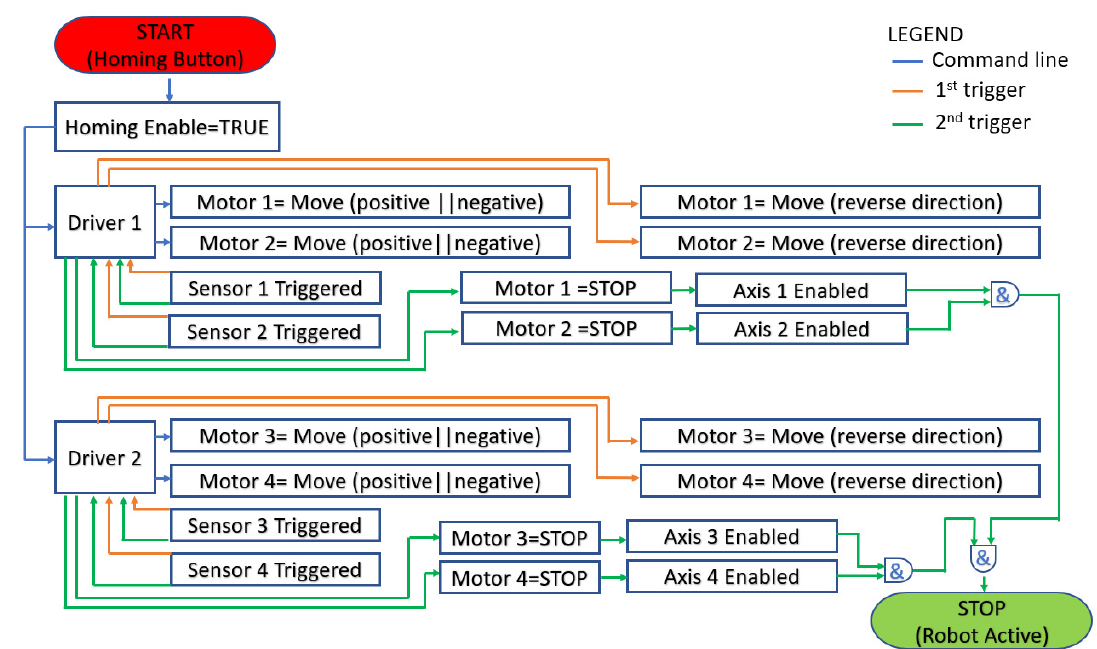
Figure 11. Homing process flowchart.